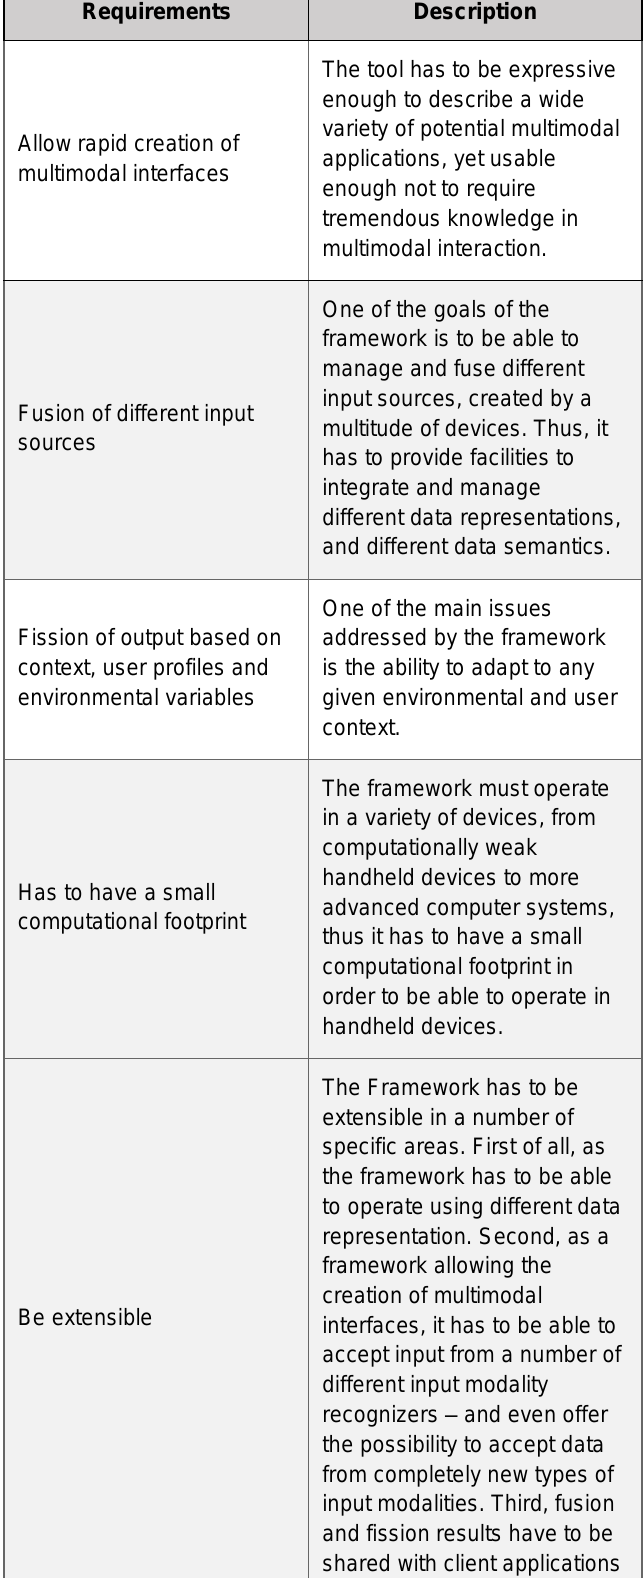
Table 2: Initial Requirements